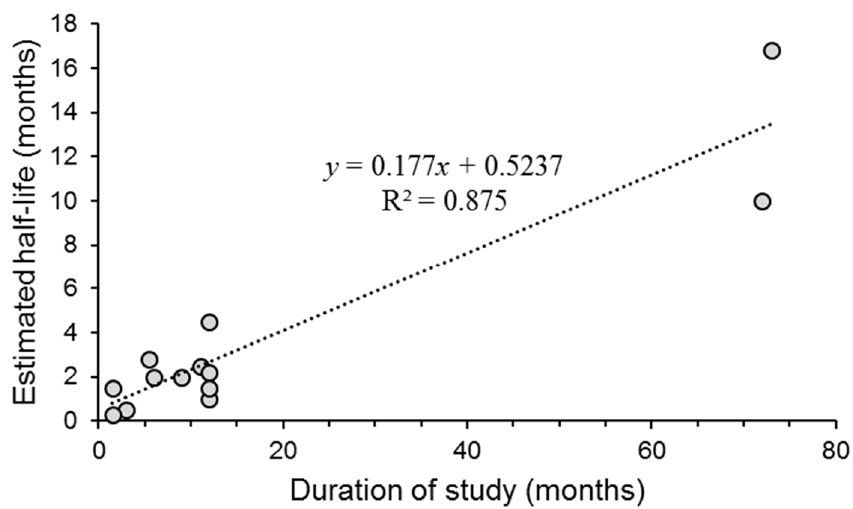
Figure 3. Correlation between estimated half-life of OBs in soil and duration of the study. Equation of the fitted line and R 2 value are given. Data from Table 3 excluding one study [29] in which OB decay was not detected.